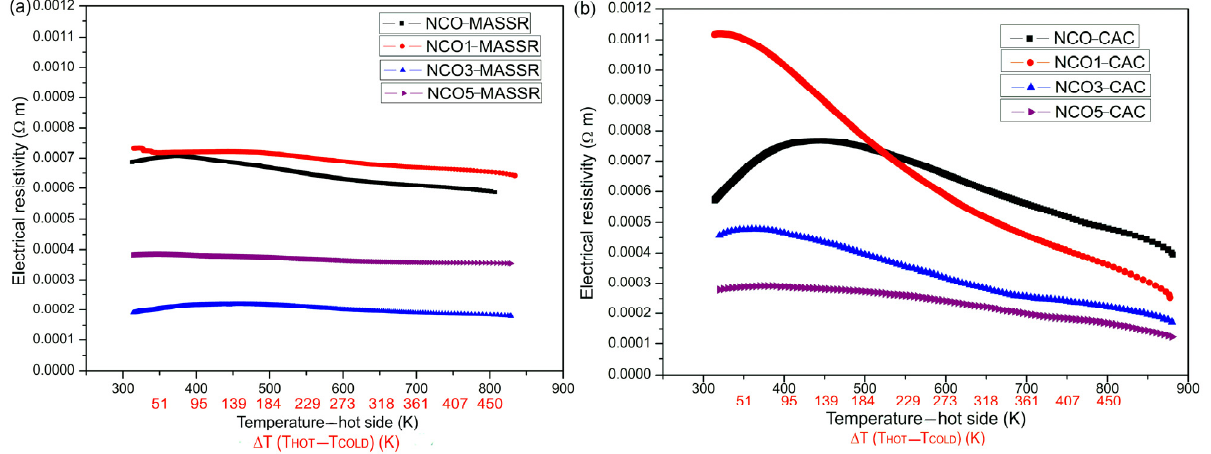
Figure 3. The electric resistivity of the ( a ) MASSR and ( b ) CAC samples for the temperature